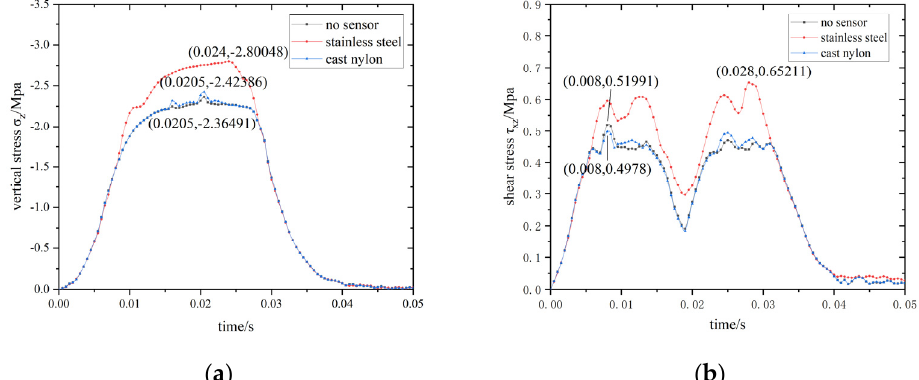
Figure 14. Maximum stress–time curve of elements at the interface under different sensor materials. ( a ) σ z -time; ( b ) τ xz -time.